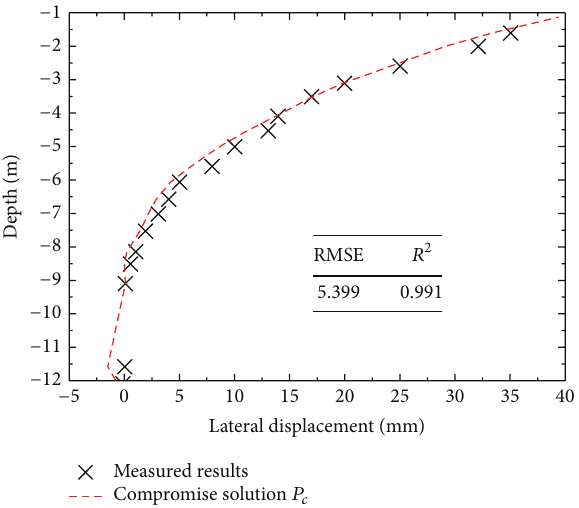
Figure 18: Comparison of measured and predicted lateral displace- ment at impact location B using compromise solution from back analysis of 1st blow at impact location